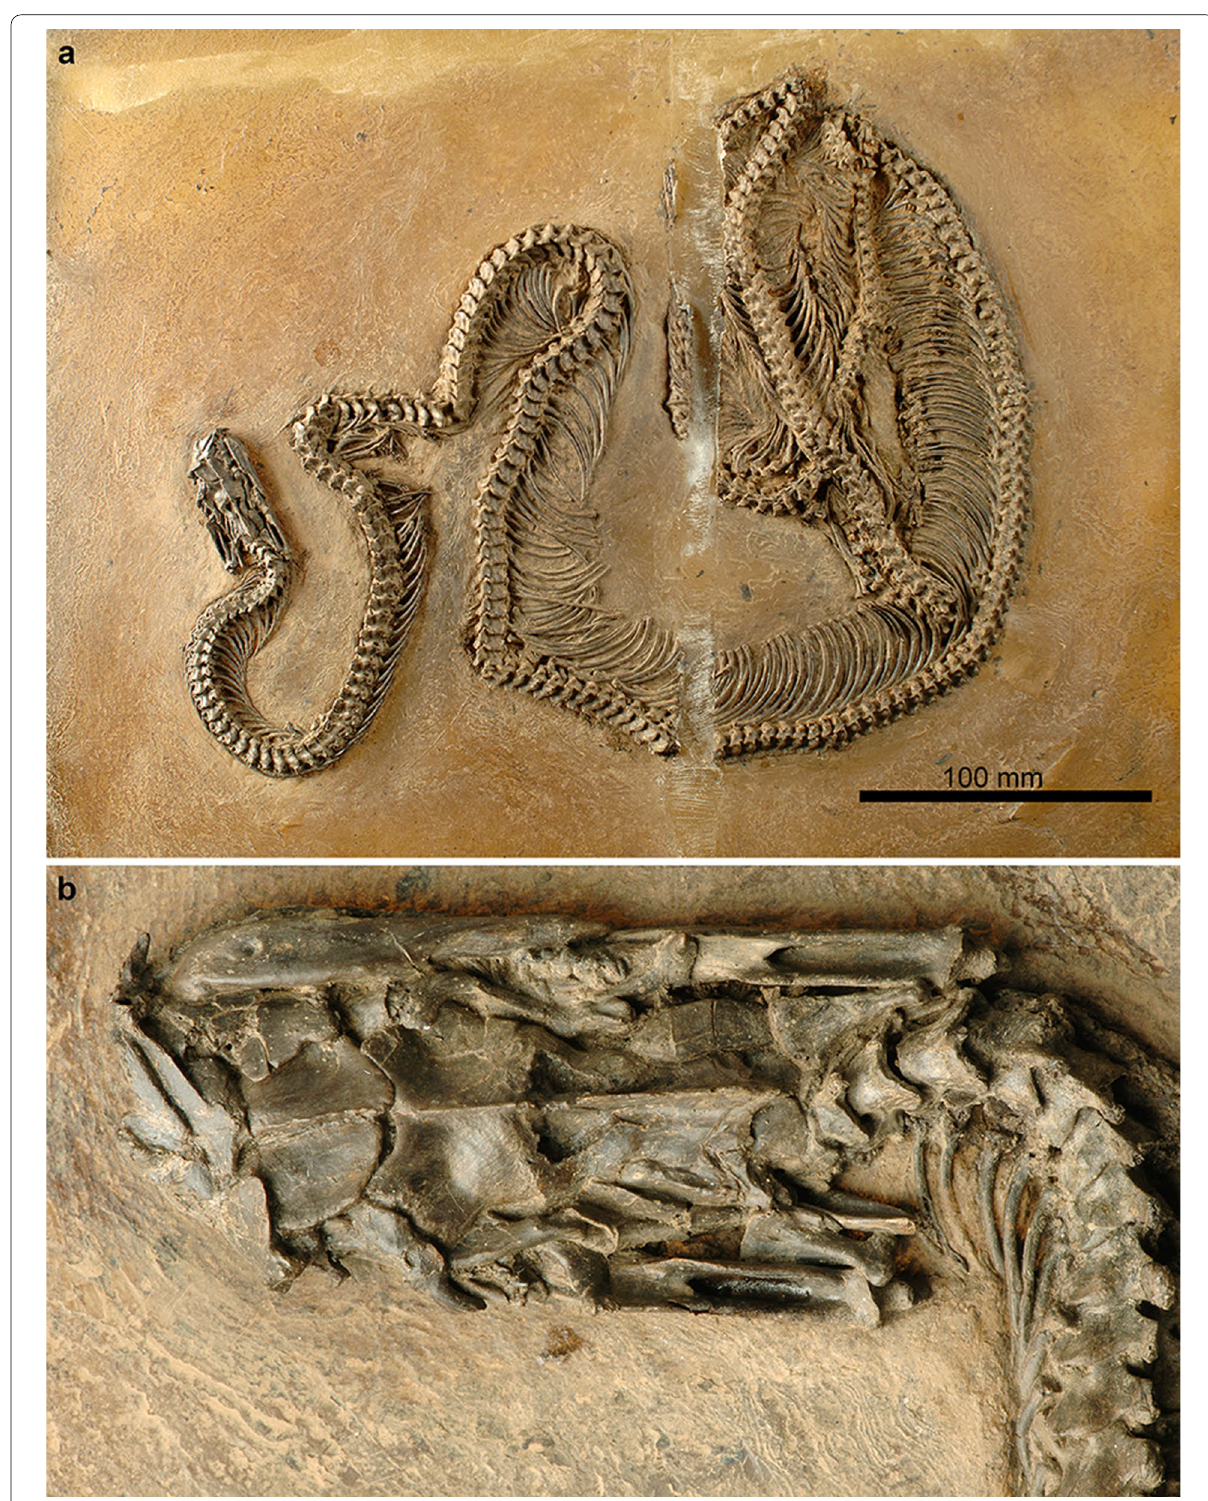
Fig. 52 Eoconstrictor fischeri from Messel: a complete skeleton with skull (SMF-ME 11398); b close up of the skull and the anterior trunk region of the same